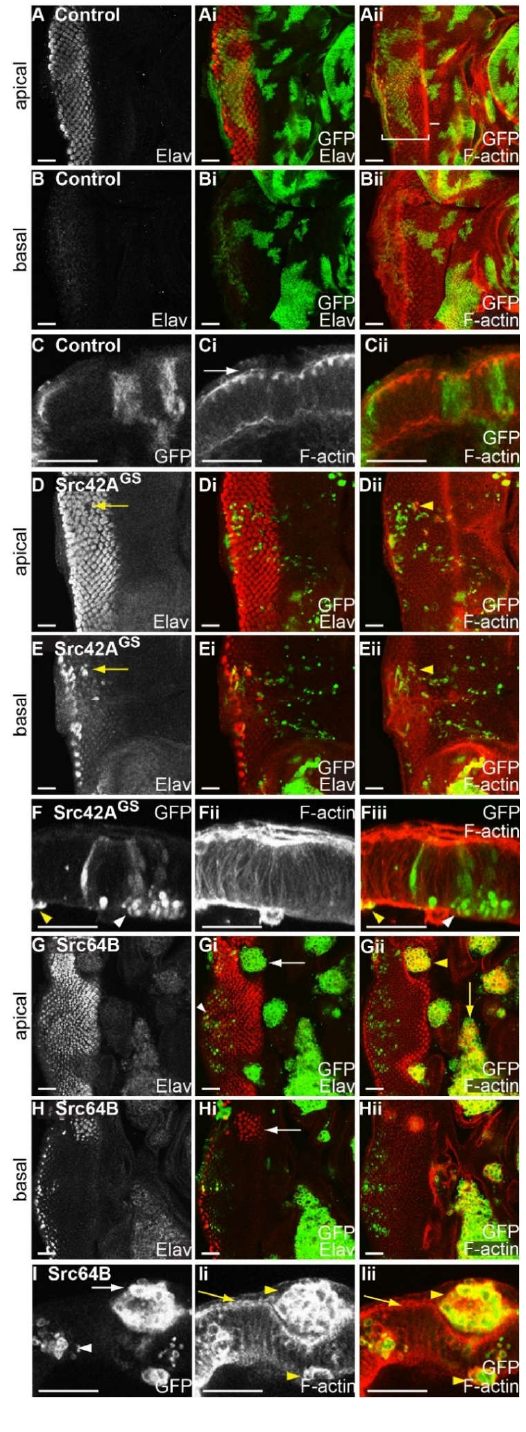
Figure 4. Expression of Drosophila Src genes results in distinct effects in eye disc clones. Confocal images, planar views or cross sections, of eye‐antennal discs: ( C , F , I ) posterior to the left. Clones are marked by GFP (green in merged images). Elav marks differentiated cells (in A , B , D , E,G , H as marked,